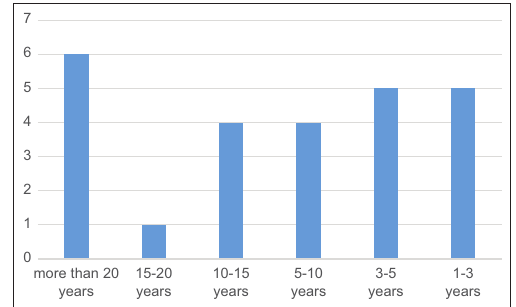
CHART 3. Length of Service. (years -. more than 20